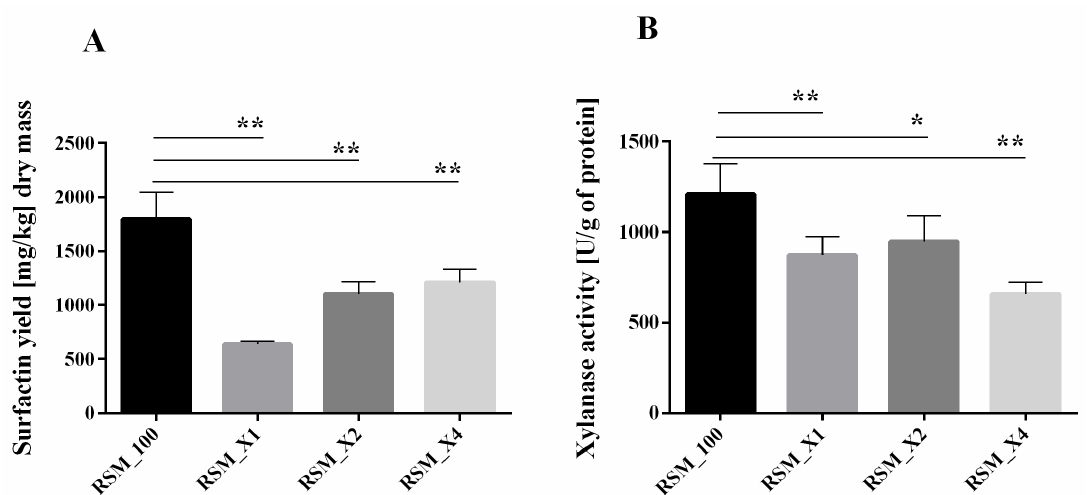
Figure 2. Surfactin yield ( A ) and general xylanase activity ( B ) obtained with B. subtilis 87Y during 24 h SSF on RSM supplemented with xylan as carbon source. X1, 2, 4—xylan addition in 10, 20 or 40 g/L. Statistical significance in all cases is presented as follows: * p < 0.05; ** p <0 .01;